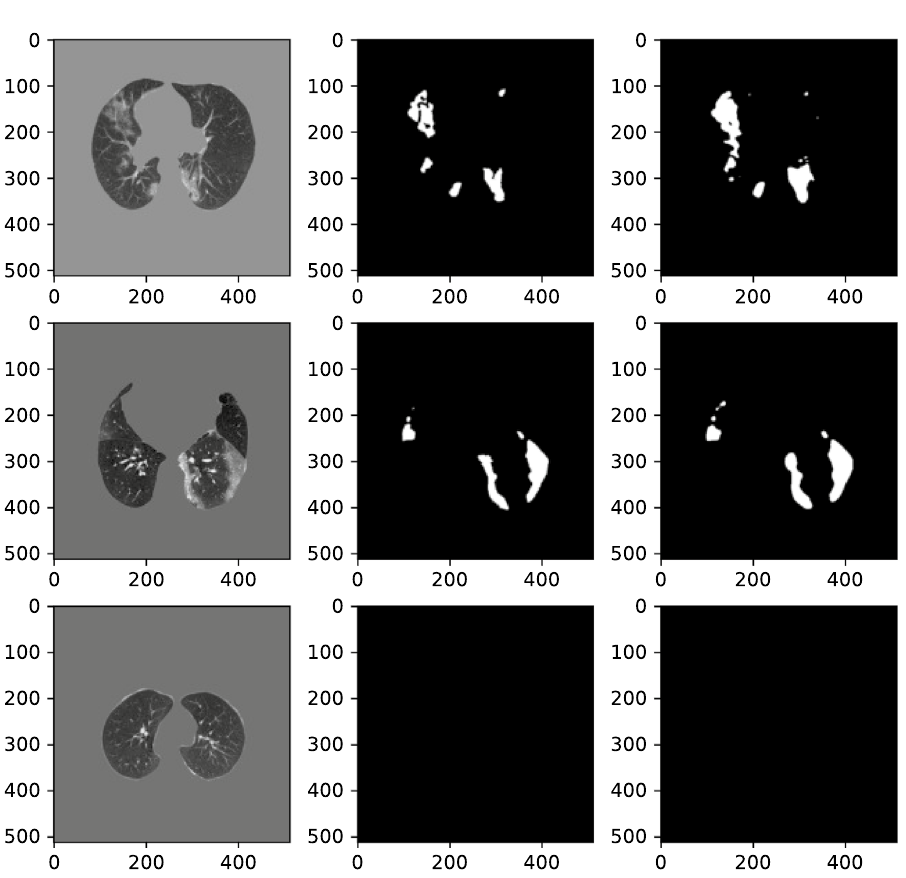
Figure 11. Qualitative evaluation of the model generalization on an external dataset. From left: Original image, Ground truth mask, Predicted mask. The model predicts a black mask for CT images with no trace of viral